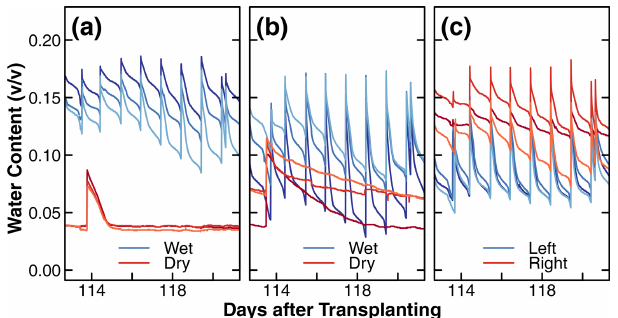
Figure 6. Changes in the dielectric soil volumetric water content ( v/v ) during days 113 to 121 after transplantation in the wet and dry compartments of treatments D and C1 and in left and right com- partments of treatment C2 (a, b, c) . The different shades of red and blue in these figures are used to distinguish between replicates. Note that the wet compartments were irrigated daily, while the dry com- partments were irrigated once a week for the majority of the ex- periments (days 40 to 140 after transplantation). The results plotted represent a typical cycle of soil water content changes. The long- term results of dielectric soil volumetric water content can be found in the